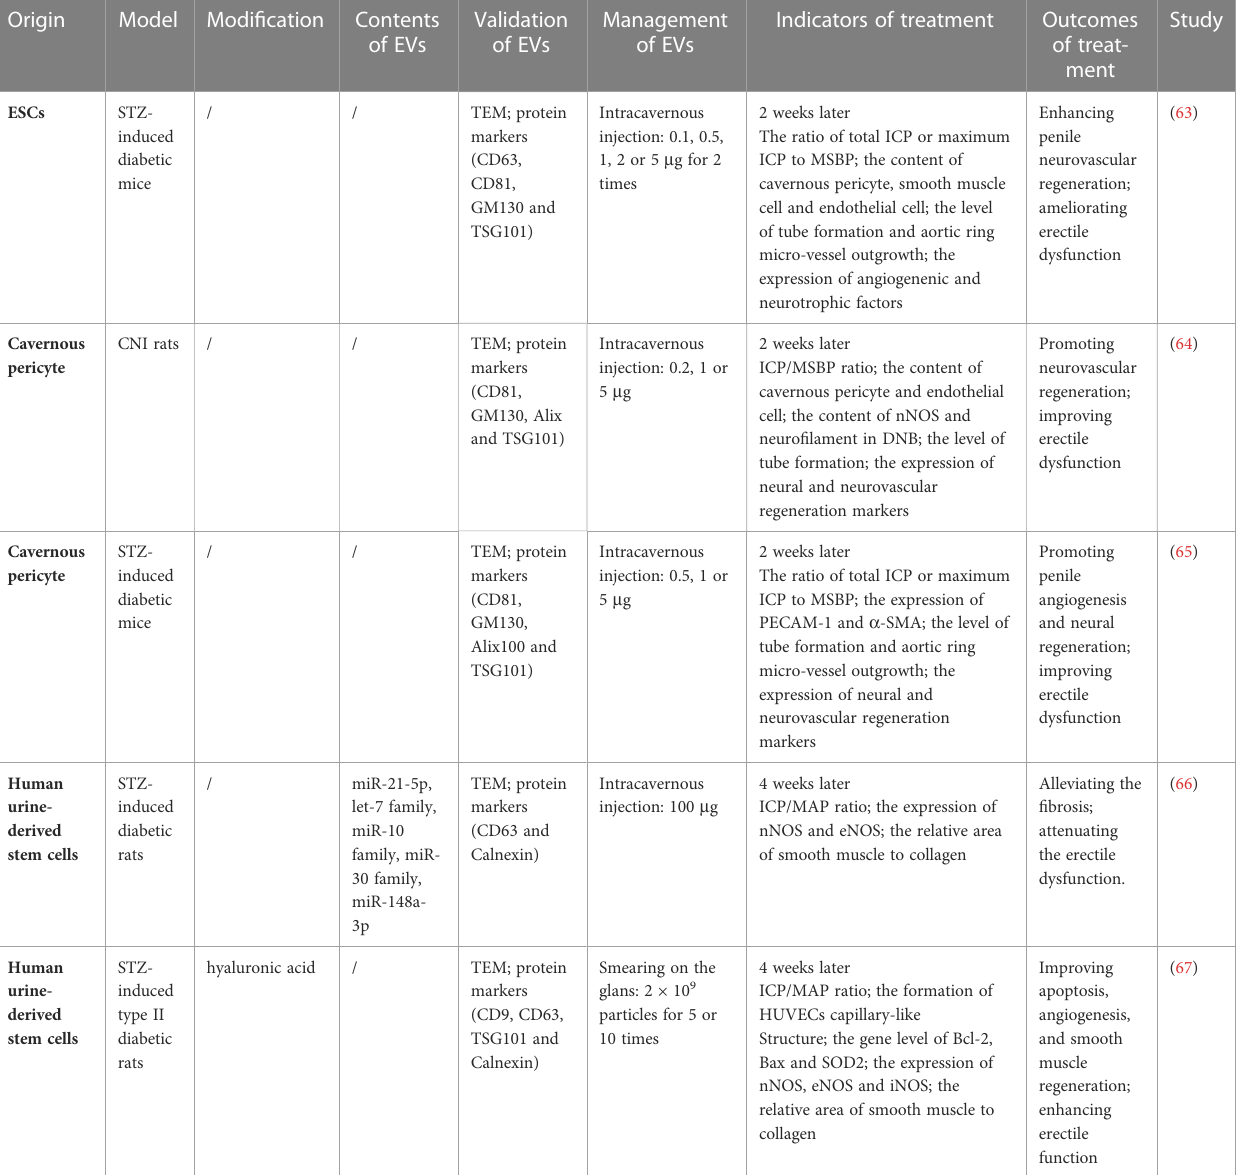
TABLE 2 Therapeutic strategies of other subsets of EVs in rat models of